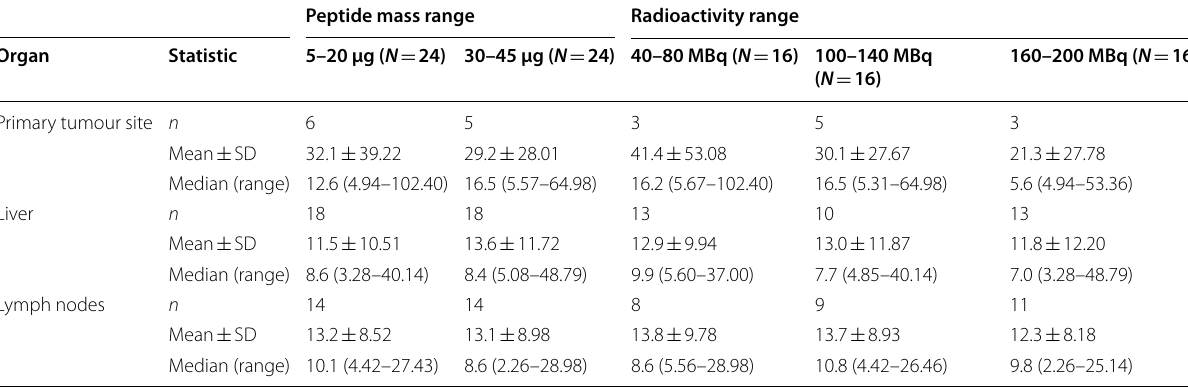
n corresponds to the number of patients with lesions in either the primary tumour site, liver, or the lymph nodes The number of patients with lesions in the bones and lungs was too small ( 1 in each category) to allow a meaningful interpretation of PET/CT scans for these organs ≤ CT computed tomography, PET positron emission tomography, SD standard deviation, SUV standardised uptake value